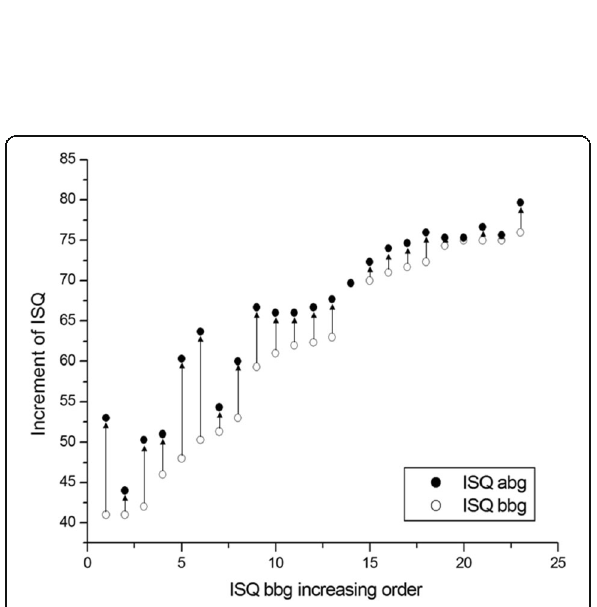
Fig. 5 The changes of mean implant stability quotient (ISQ) for all the implants after bone graft procedures in both the low primary stability group (LPSG) and the high primary stability group (HPSG). 65 was defined as the